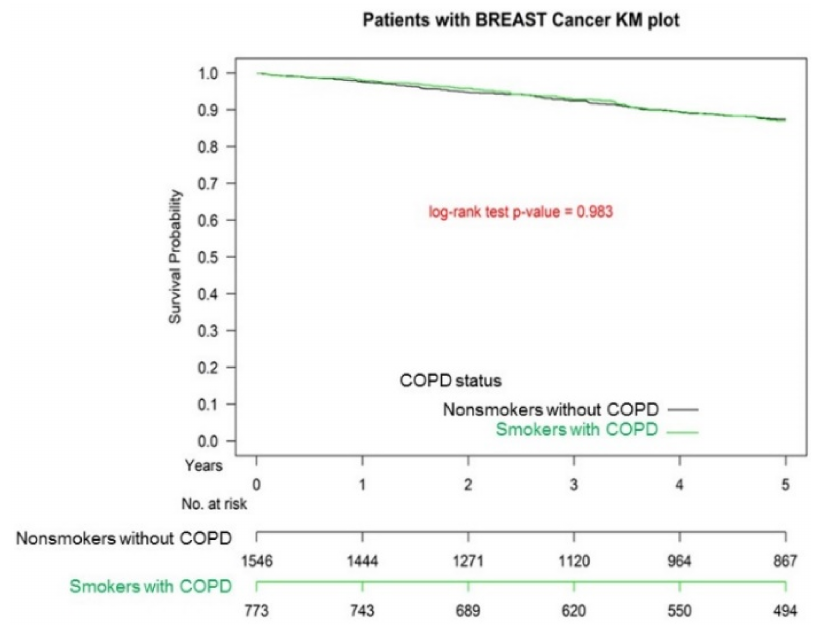
Figure 1. Kaplan–Meier survival curves of patients with invasive ductal carcinoma with or without smoking-related chronic obstructive pulmonary disease (COPD) before breast surgery.